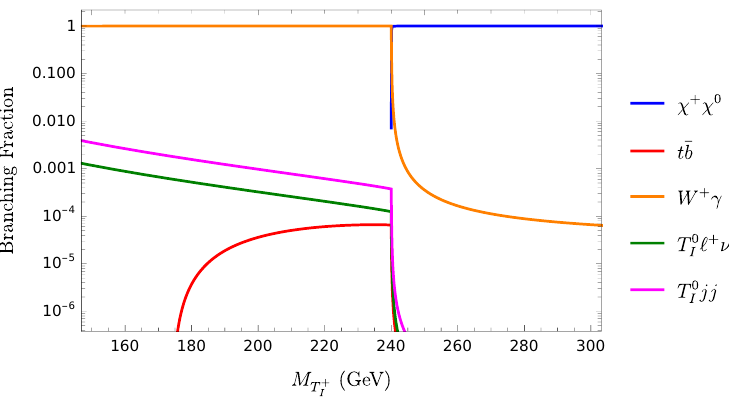
Figure 8 . Branching fractions for decay of the odd charged triplet. Here the splitting between the charged and neutral state is fixed at 3 GeV, and all other parameters are as in benchmark